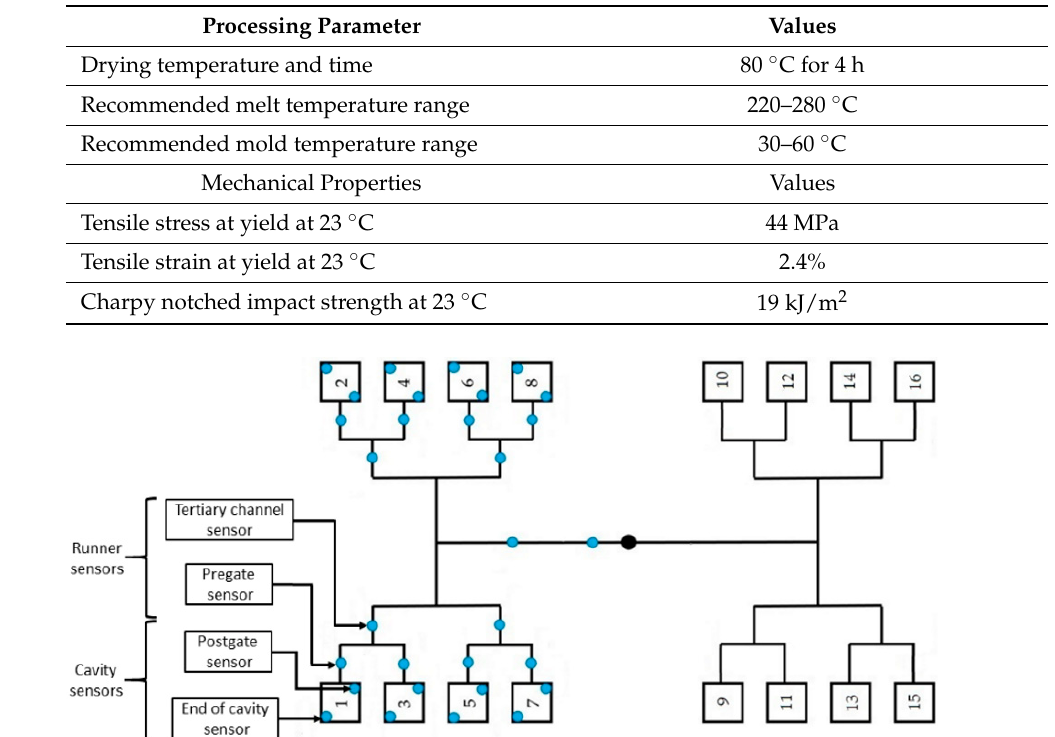
Table 1. Recommended processing parameters by the manufacturer (Terluran GP-35 ABS) and the mechanical properties of the material.